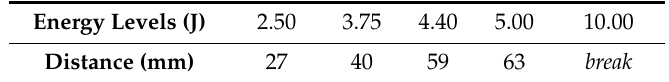
Table 6. Distance travelled by the matrix cracking on the bottom surface of EP-BF30 at di ff erent impact energy